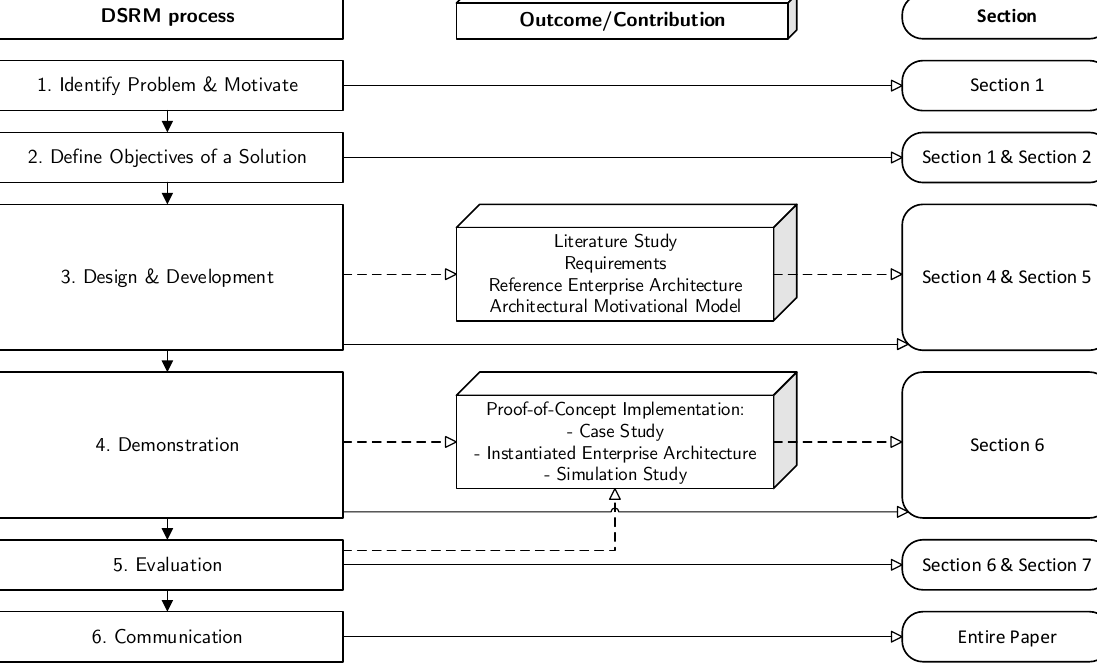
Figure 1. Research